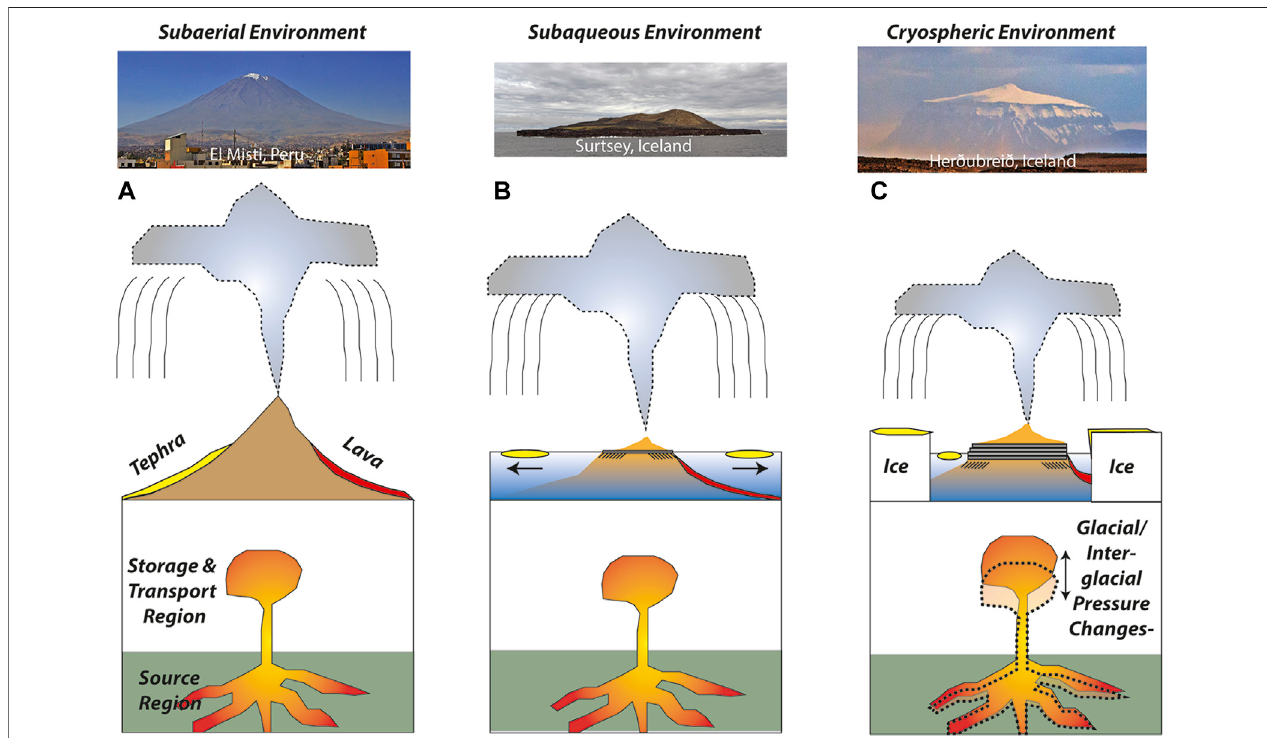
FIGURE2| Schematicillustrationsofthethreeeruptionenvironments. (A) Subaerialeruptionsessentiallyshownovariation,exceptpotentiallythatassociatedwith changesinbarometricpressure.Thisenvironmentimposesveryfewconstraintsonthedistributionsofpyroclastic depositsandlavaeffusions. (B) Aquaticeruptionscan alsoexperiencechangesinbarometricpressure,butthosechangesareveryminorcomparedtothehydrostaticpressure,whichisstaticintheshort-termbutwhichcan change as eruption products accumulate at the vent. Deposits of pyroclastic materials can be distributed widely by water transport, and the physical properties of the aqueous environment do not strongly impede the movement of lava effusions. (C) Cryospheric eruptions can also experience barometric pressure changes, but again these are minor compared to cryostatic/hydrostatic pressures. For this environment pressure changes have the potential to be dynamic instead of static, as meltwater produced during the eruption can leave the vent area, leading to reductions in pressure on the order of several MPa. Ice is also very capable to limiting the distribution of pyroclastic materials and lava